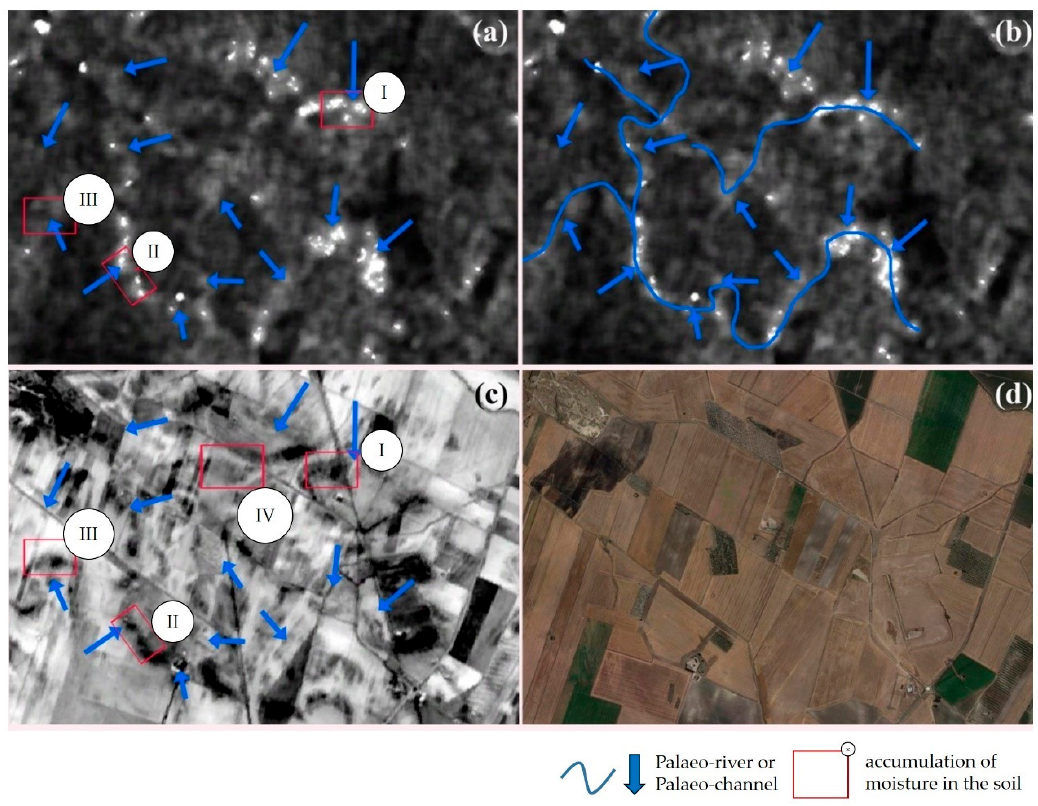
Figure 9. Località Ciamponetto (Neolithic and Roman settlements) palaeo-landscape (see Figure 8, I for its location), including palaeo-rivers and palaeo-channels observed from: ( a ) VV S-1 data acquired on 19 October, 2019; ( b ) mapping of the palaeo-hydrography on the basis of Figure 8a; ( c ) S-2 based soil map acquired on 20 October, 2019; ( d ) Google Earth image acquired on 10 October, 2014.